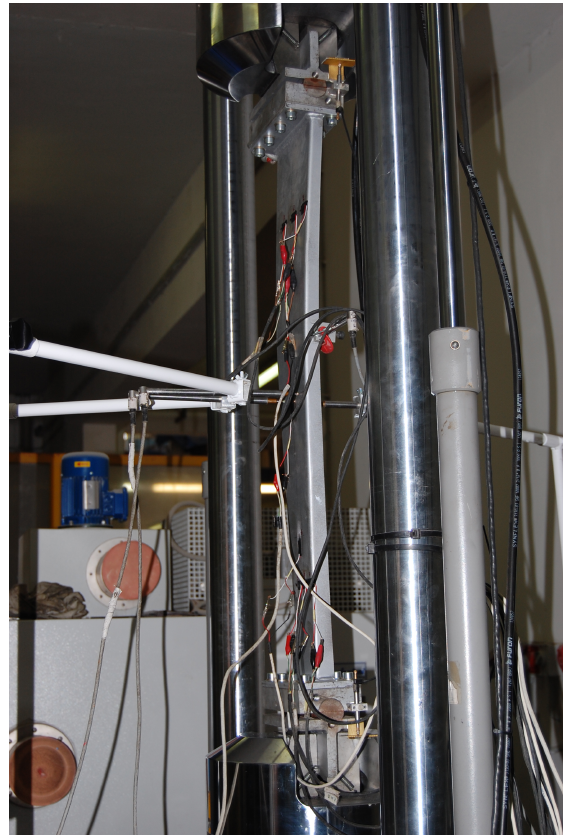
Figure 9. Buckled configuration of the